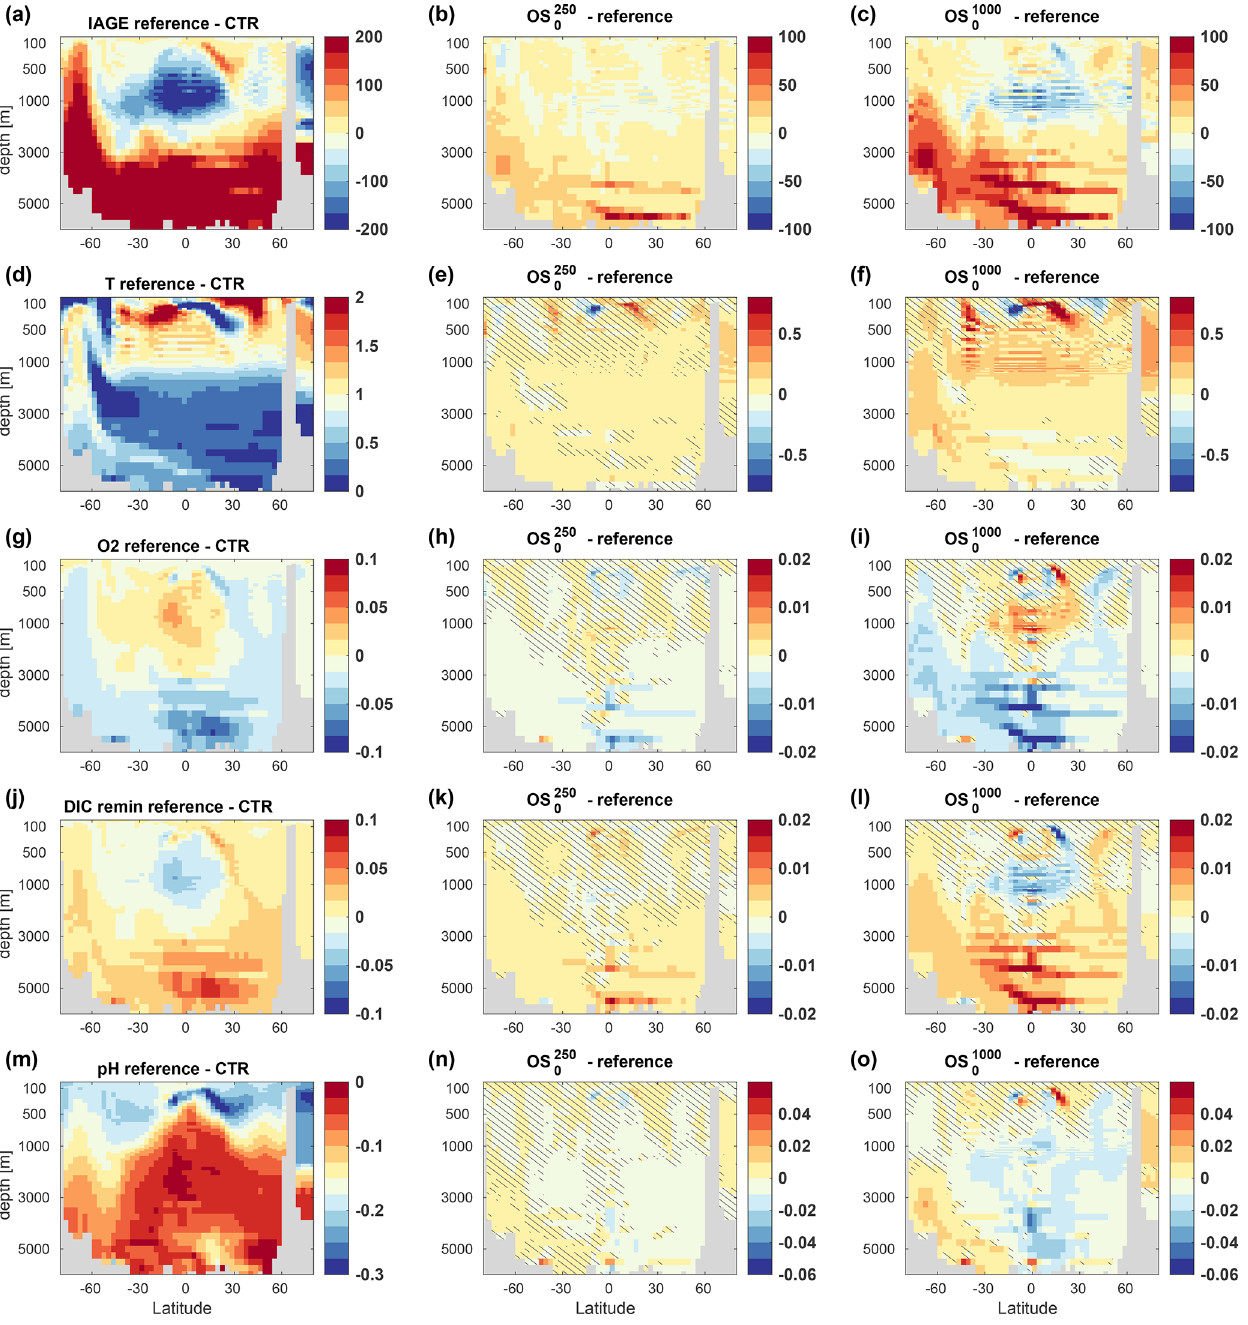
Figure A2. As Fig. 10 but showing REV 195 for the short overshoot duration.